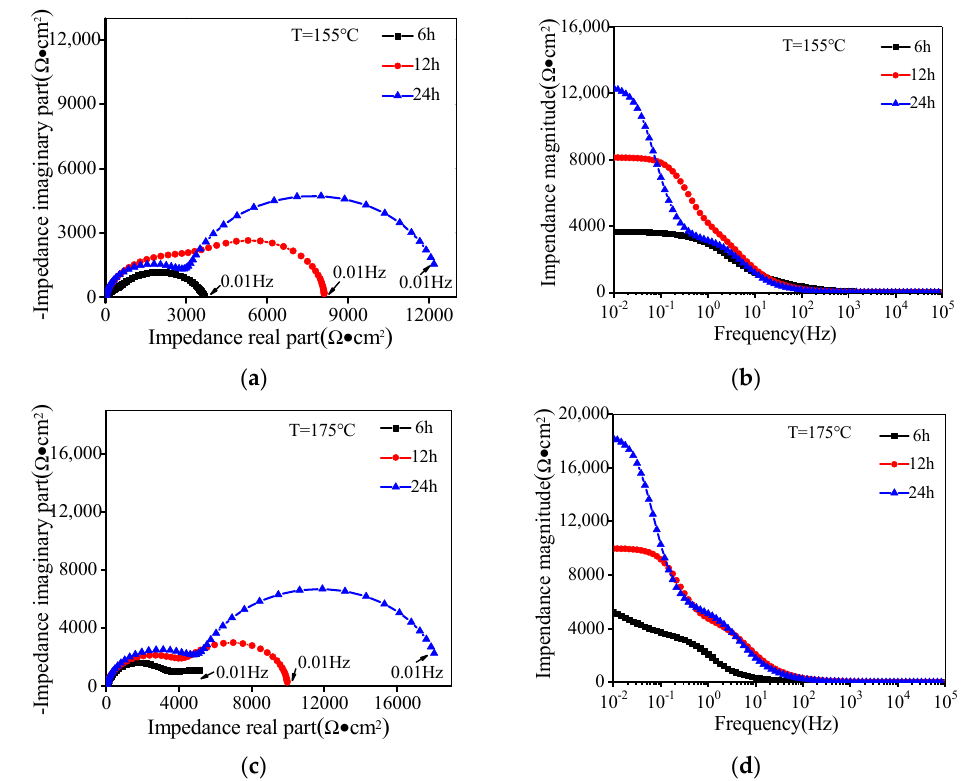
Figure 2. Electrochemical impedance spectroscopy: ( a ) Nyquist plots (T = 155 °C); ( b ) Bode diagrams (T = 155 °C);. ( c ) Nyquist plots (T = 175 ° C); ( d ) Bode diagrams (T = 175 ° C).